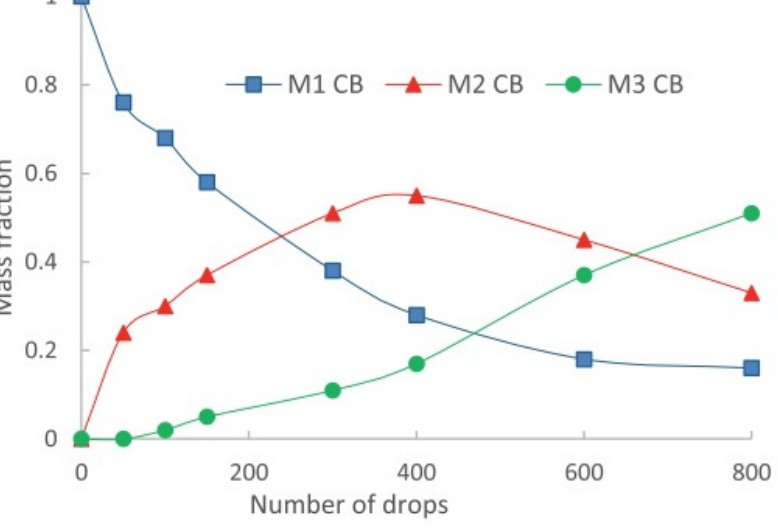
Figure 1. Mass fractions vs. different numbers of drops [19].